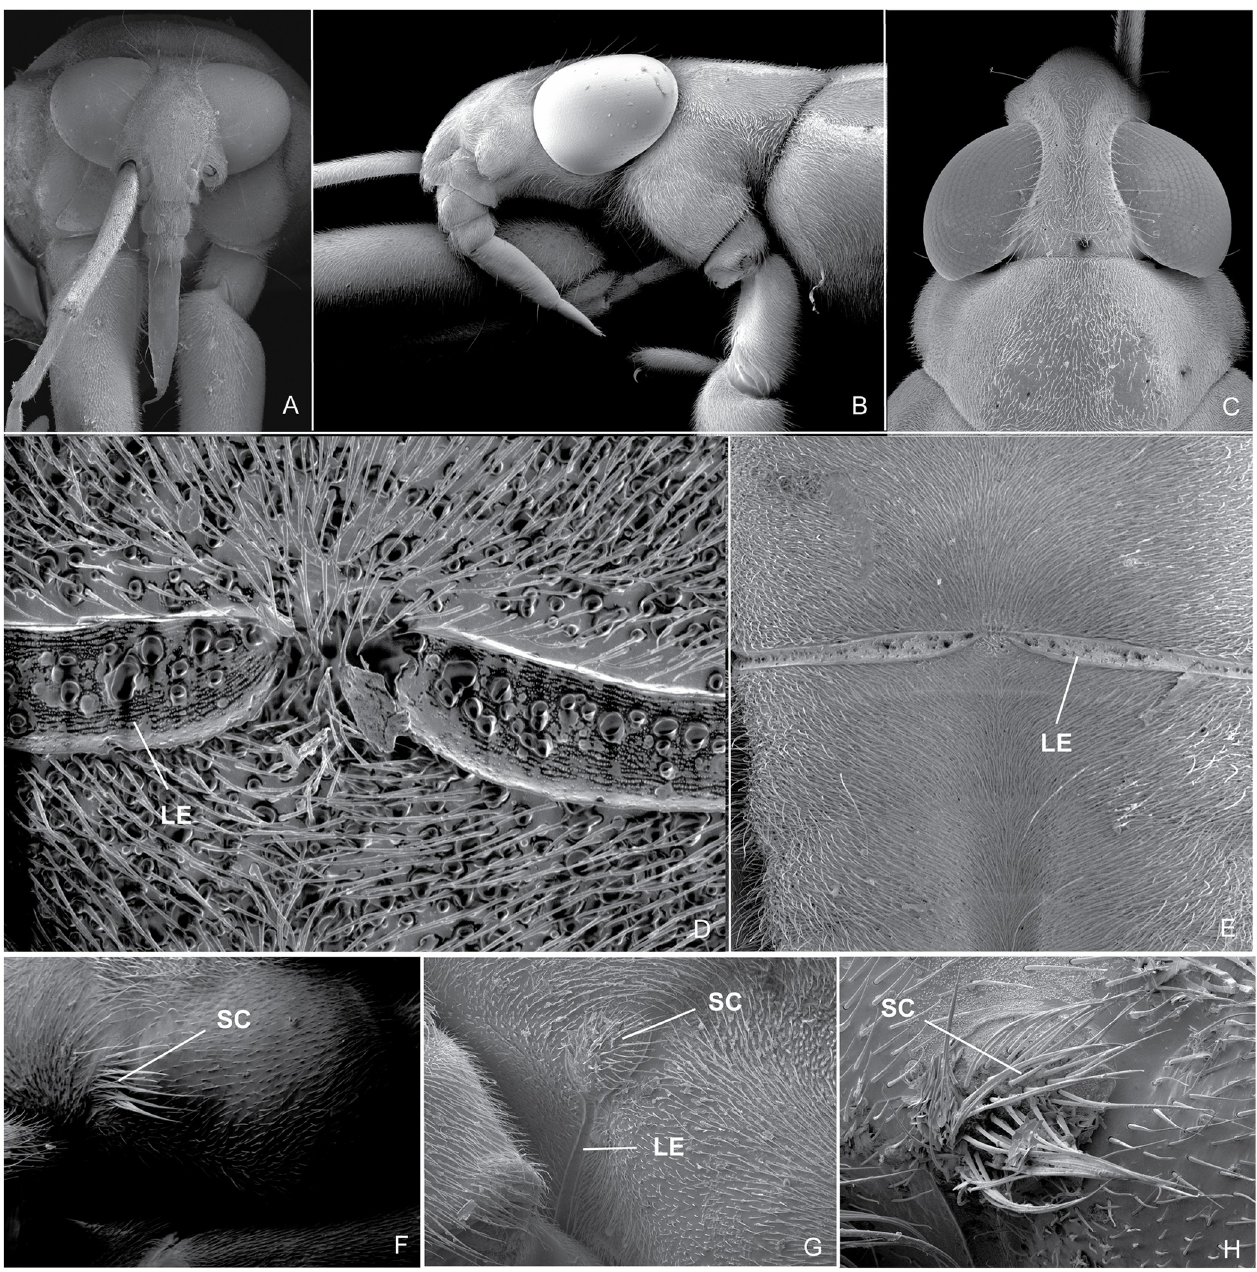
Fig 5. Scanning electron micrographs. (A) P . sumaco , head, frontal view; (B) B . thomasi comb. Nov. , head, lateral view; (C) P . unidentatus , head, dorsal; (D) P . shuar , scent groove, ventral view; (E) P . osborni , scent groove, ventral view; (F) B . thomasi comb. Nov. , lateral evaporatorium of metathoracic scent apparatus, lateral view; (G) P . sumaco , lateral evaporatorium of metathoracic scent apparatus, lateral view; (H) P . osborni , lateral evaporatorium of metathoracic scent apparatus, lateral view. SC: scent groove; LE: lateral evaporatorium of metathoracic scent apparatus.